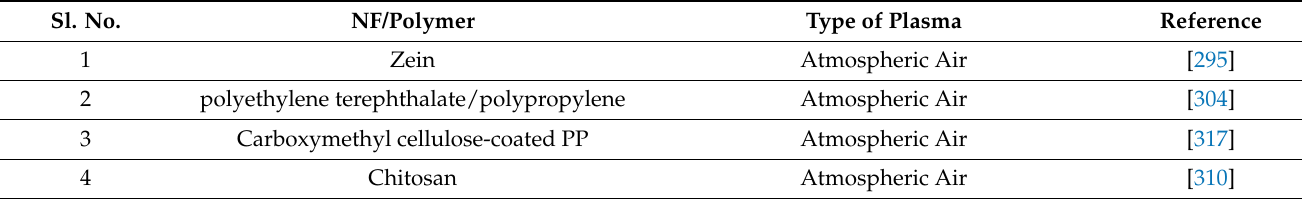
Table 7. Reported some studies of plasma-treated polymers for packaging applications. Sl.